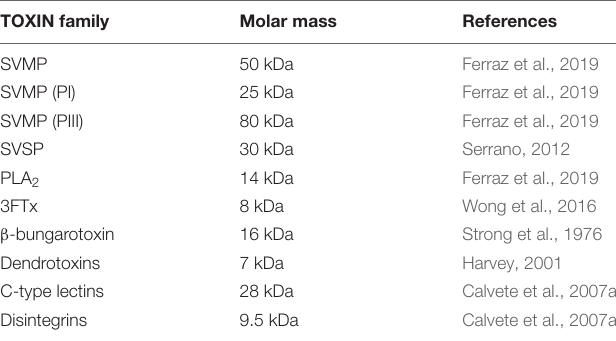
TABLE 2 | Average Molar Masses of All Toxin Families Considered to be Medically Relevant. TOXIN family Molar